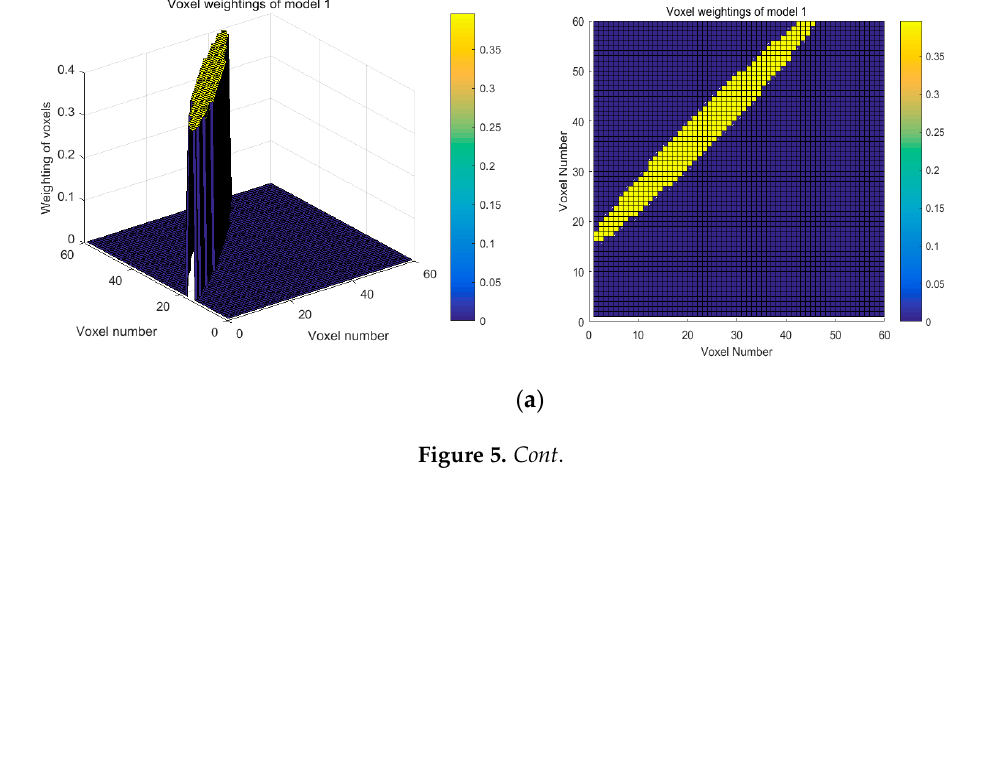
Figure 4. The coverage of different ellipse weight models ( a ) Model 1; ( b ) Model 2; ( c ) Model 3.